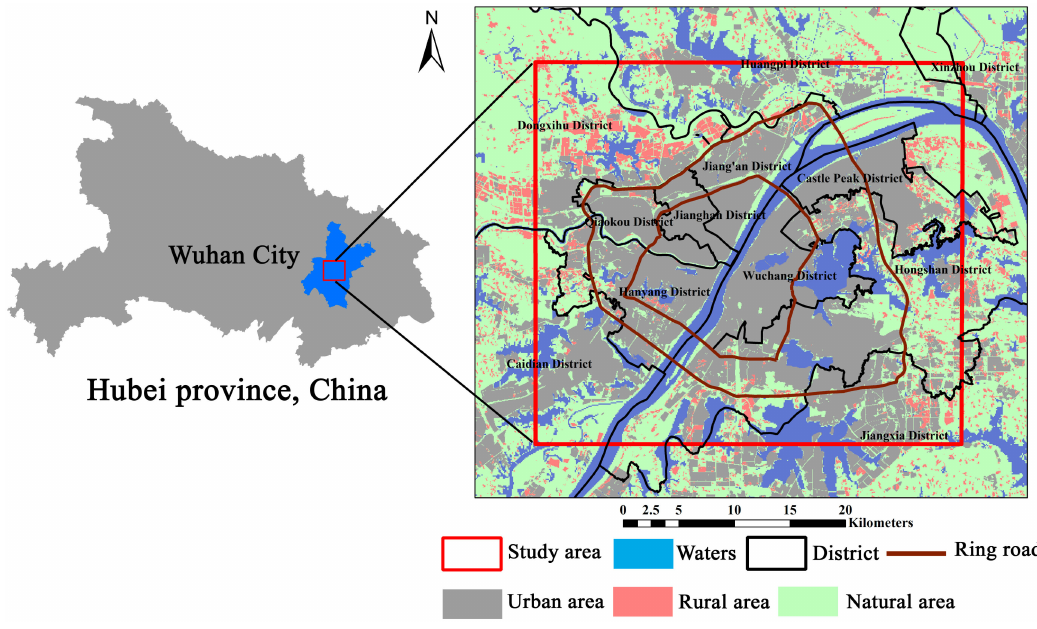
Figure 1. Map of study area.